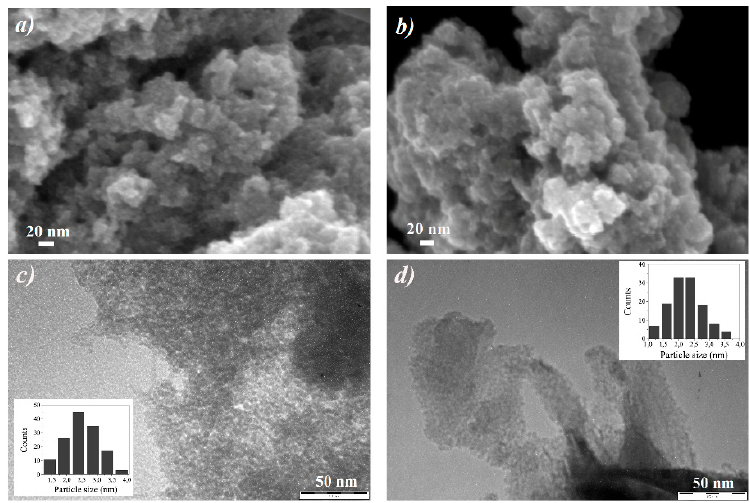
Figure 3. Ferrihydrite NPs from diluted suspensions (0.01 g/L) prepared on TEM suitable grids. FE-SEM images of: ( a ) Fh 0.1M , ( b ) Fh 1M . TEM images of: ( c ) Fh 0.1M , ( d ) Fh 1M . Particles size distributions (insets) carried out on a population of ca. 130 NPs.